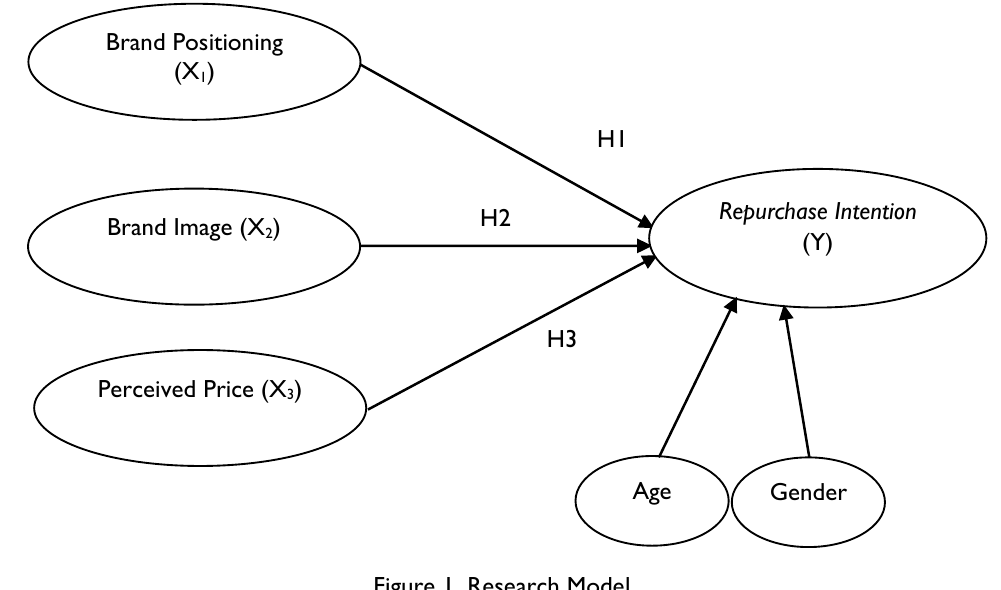
Figure 1. Research Model